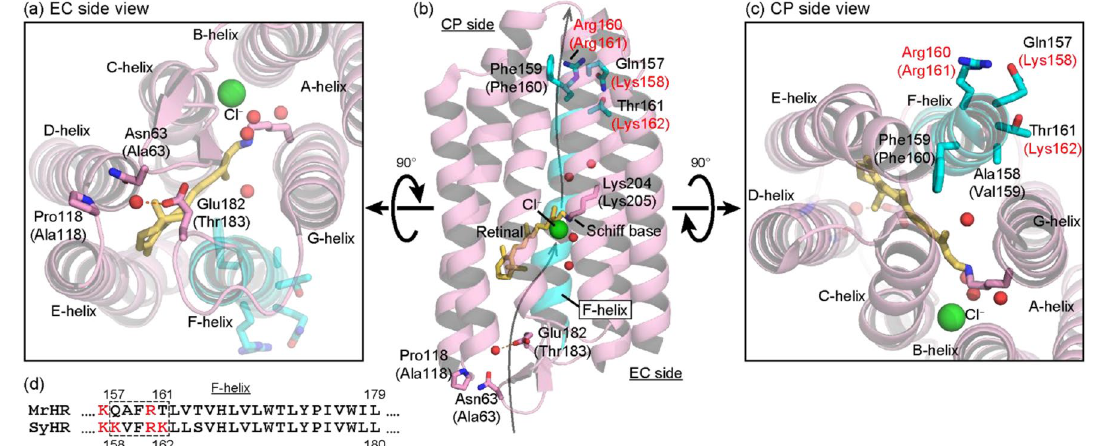
Figure 1. The positions of key residues in this study. The overall structure of MrHR is shown in ( b ) with the residues mutated in this study, and expanded views from the EC and CP sides are shown in ( a ) and ( c ), respectively (PDB code, 6K6I). The corresponding residues in SyHR are indicated in parentheses, and water molecules inside the protein are shown as red spheres. Out of seven helices, only the F-helix is colored light blue. In Panel ( b ), a putative anion transport pathway is indicated with gray arrows. ( d ) The amino acid residues in the F-helix are compared between MrHR and SyHR. In the CP end regions (the upstream region), SyHR has more basic residues (red letters) than MrHR. The five residues enclosed by the dashed box, which are shown with blue sticks in the upper panels, are mutually replaced between MrHR and SyHR. This mutation is referred to as